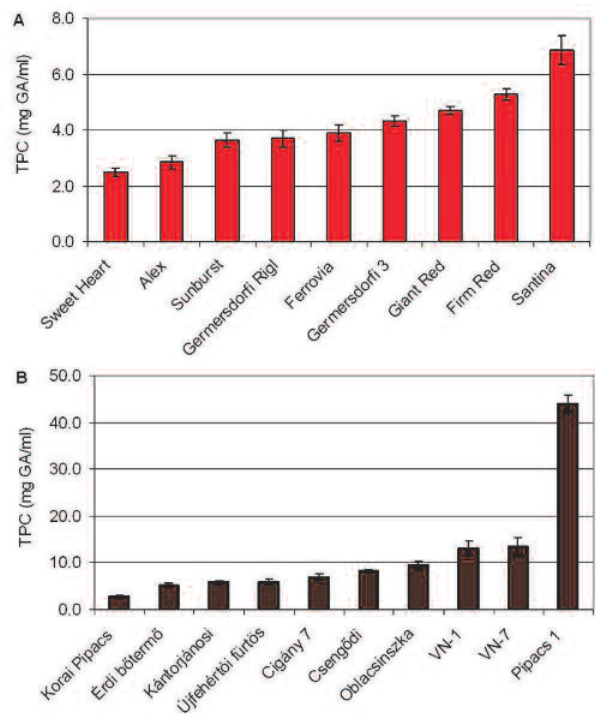
Figure 3. Total phenolic content of sweet (A) and sour (B) cherry cultivars